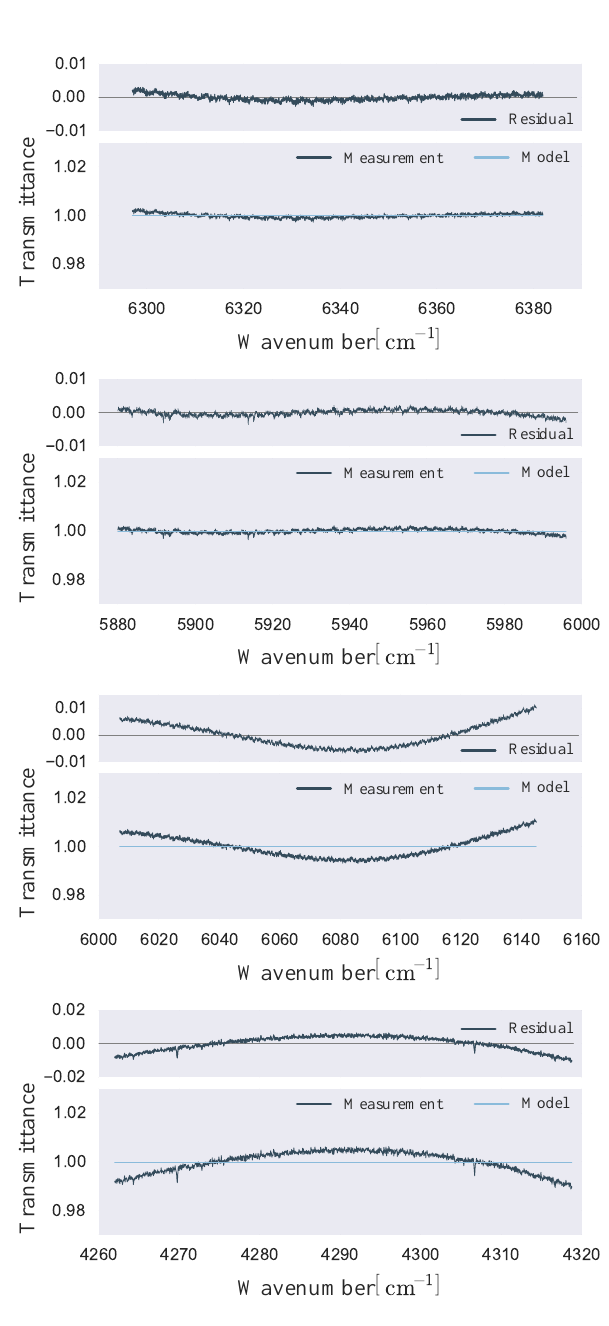
Figure A3. Same as Fig. A1 but for Karlsruhe cavity spectra.